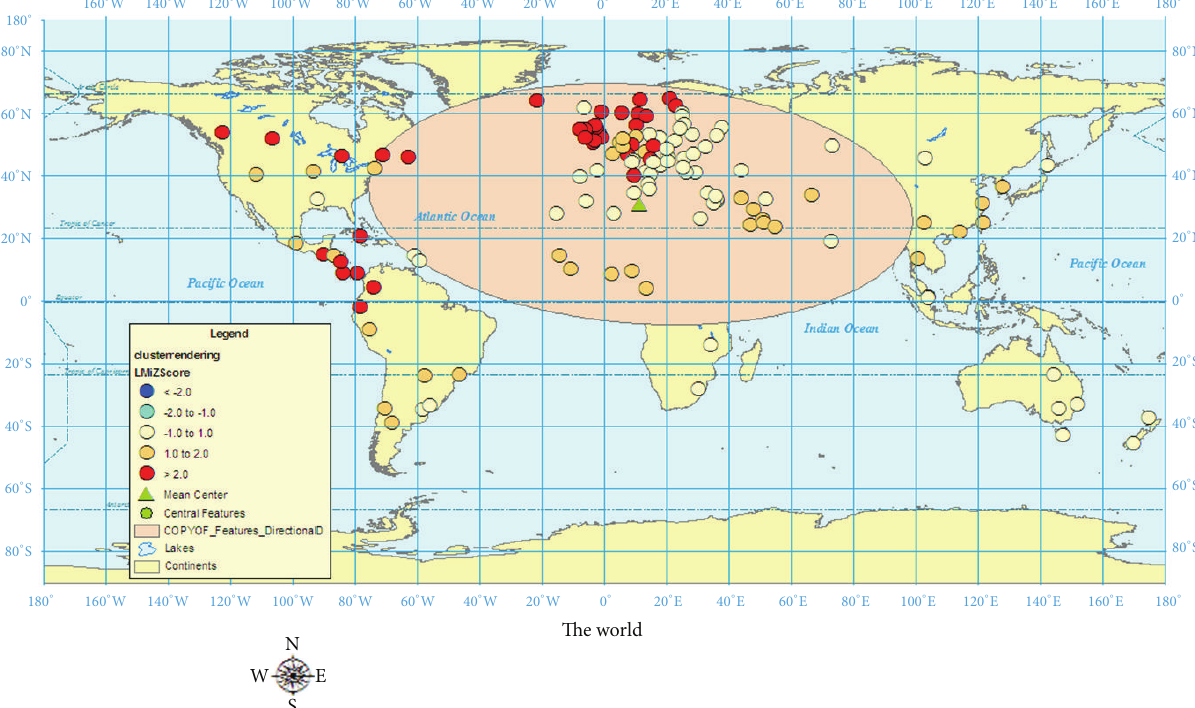
outliers are found in Eastern Europe, South America, and